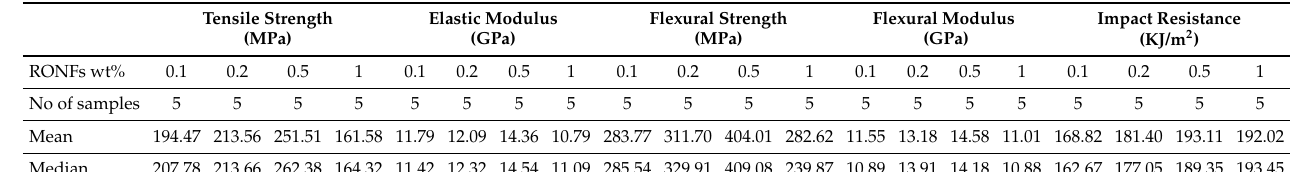
Table 4. Statistical parameters of the RONFs strengthened glass fiber composites.